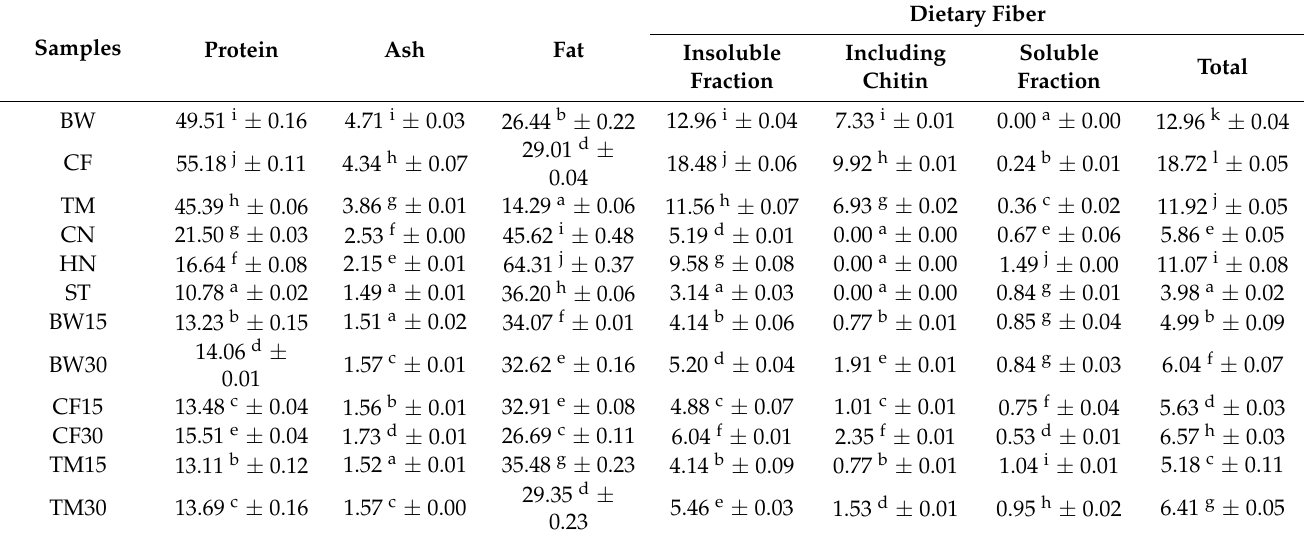
Table 1. Chemical composition of raw materials and products (g/100